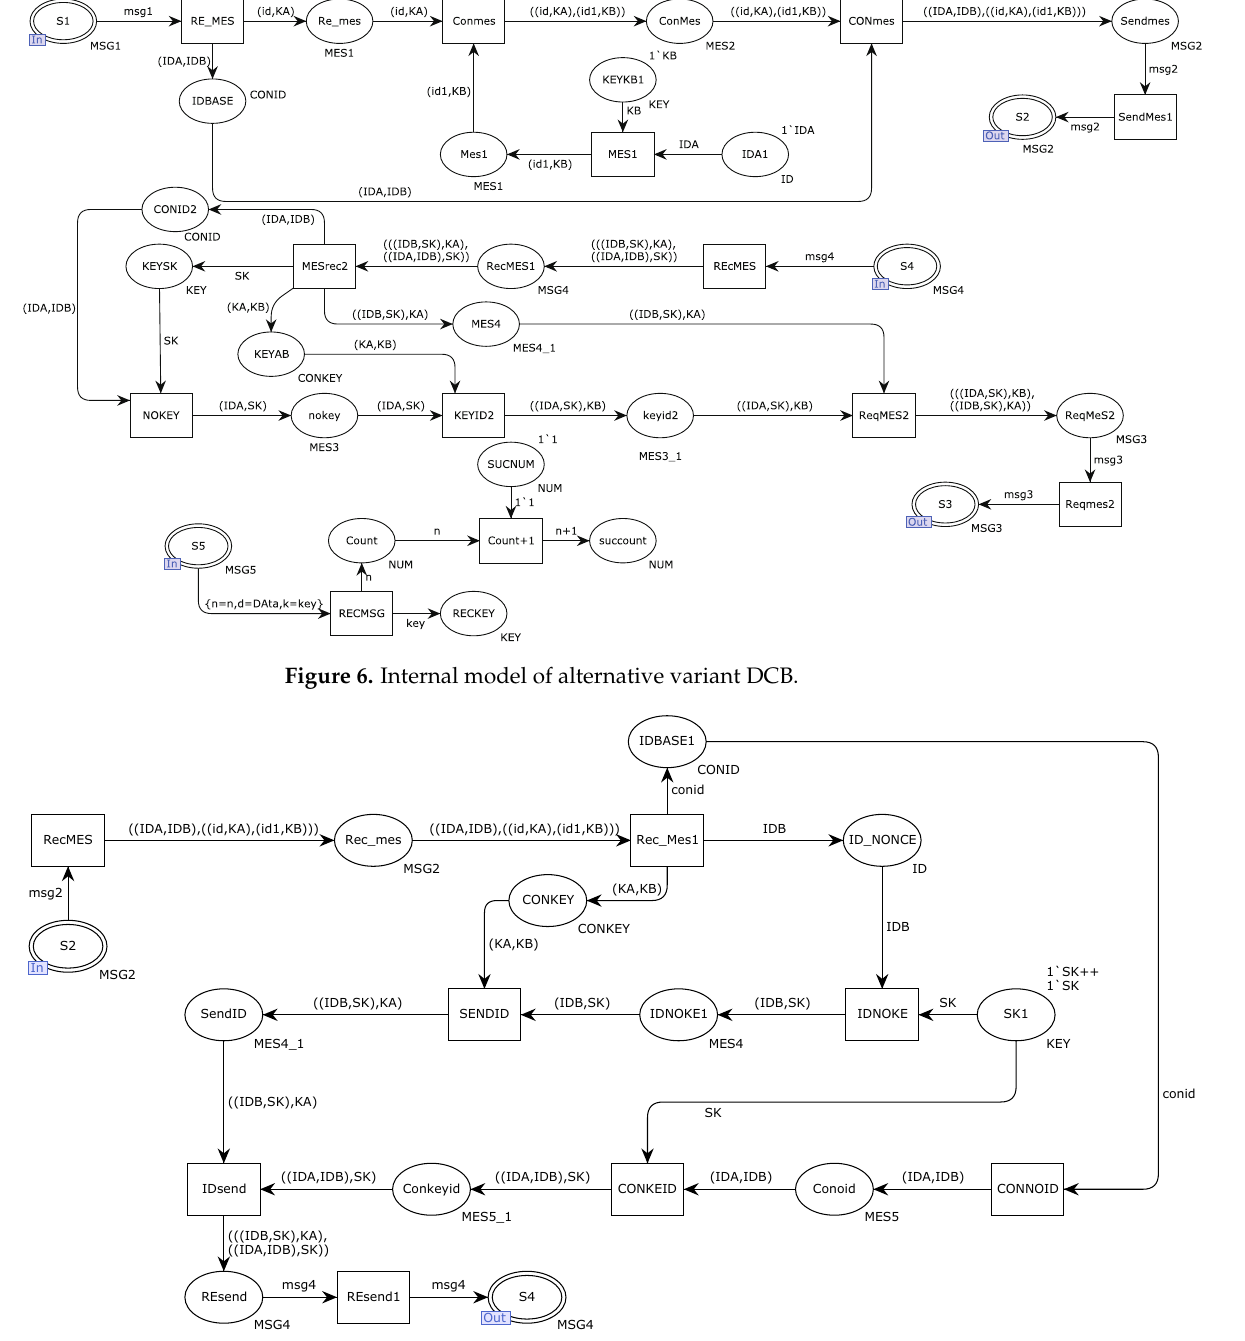
Figure 7. Internal model of alternative variation